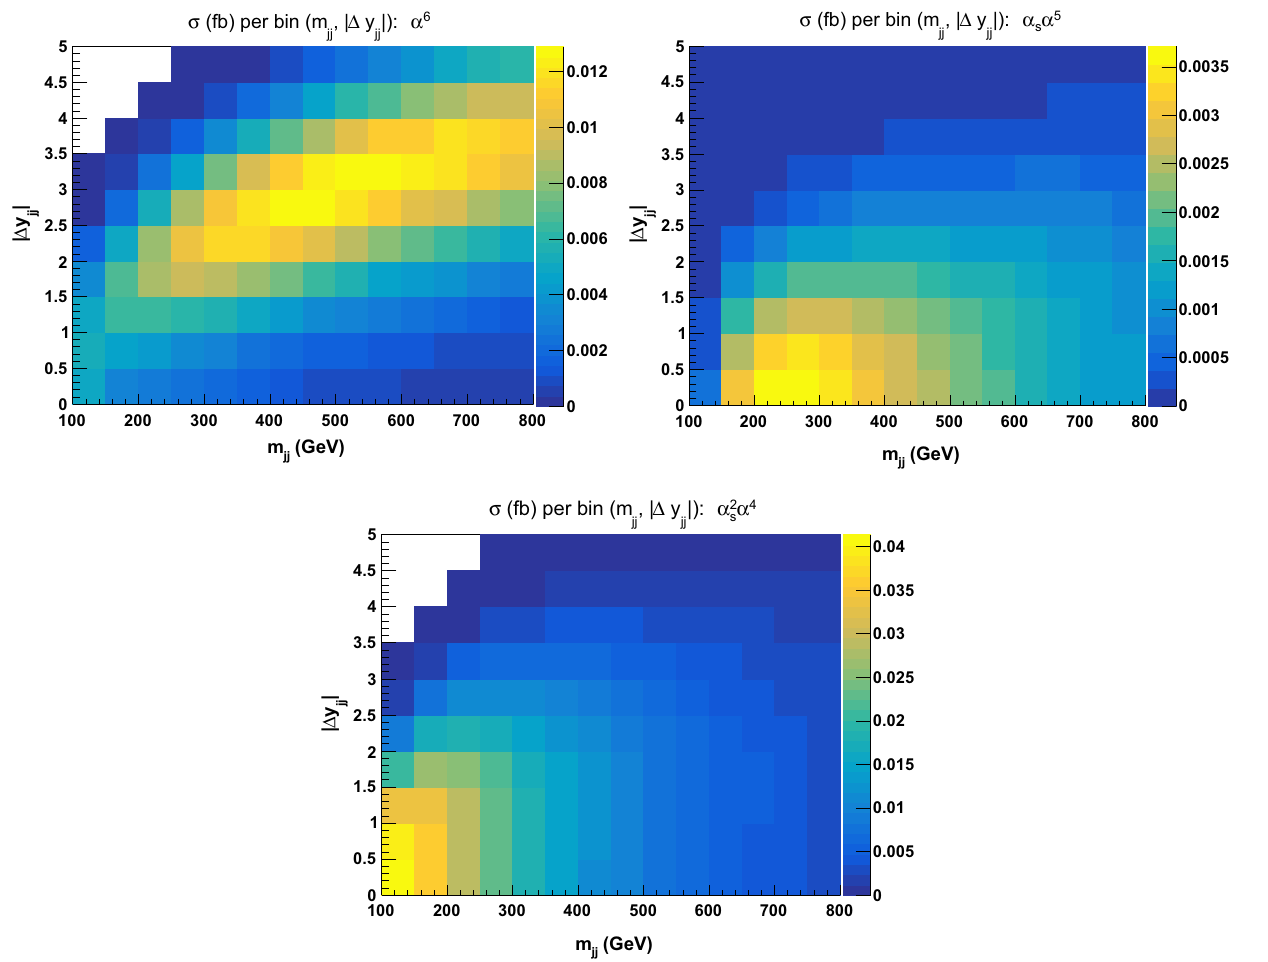
Fig. 3 Double-differential distributions in the variables m jj and | Δ y jj | for the three LO contributions of orders O (α 6 ) (top left), O (α s α 5 ) (top right), and O (α 2 s α 4 ) (bottom). The cuts applied are the ones of Sect. 3.3 but no cuts on m jj and | Δ y jj | are applied